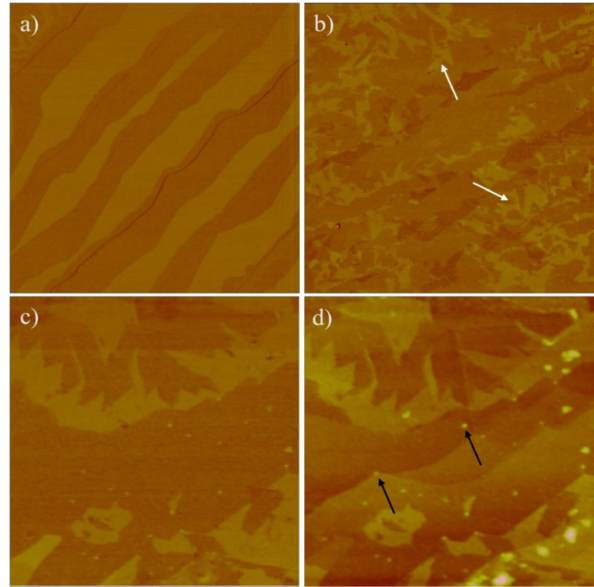
Figure 1. Atomic force microscopy (AFM) phase images of ( a ) pristine and ( b ) N + ion-implanted epitaxial graphene (EG) on SiC at 1 × 10 14 ions / cm 2 fluence over a scan area of 10 µ m × 10 µ m with white arrows showing fragmentation of Monolayer (ML) graphene; ( c ) phase and ( d ) height image of N + ion-implanted EG on SiC at 1 × 10 14 ions / cm 2 fluence over scan area 2 µ m × 2 µ m with black arrows showing presence of